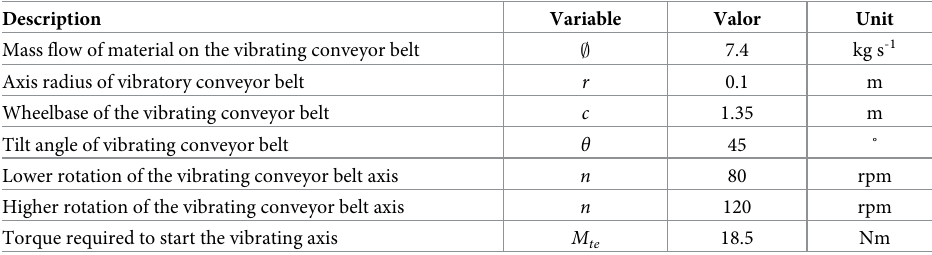
Table 1. Vibratory conveyor belt data used to dimension the hydraulic motor.